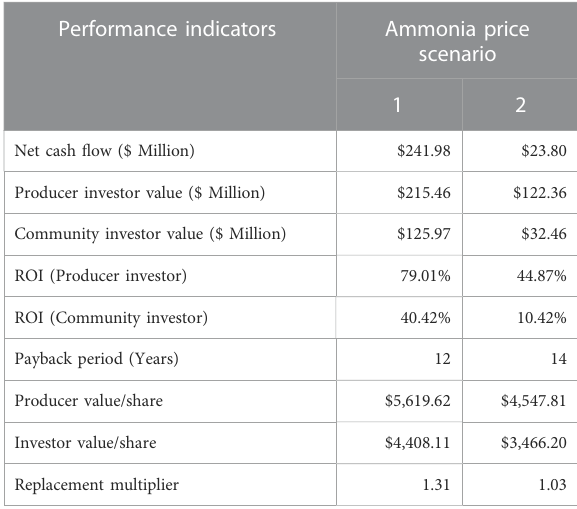
TABLE 8 Discounted performance indicators under debt fi nancing I (producers = 35%; community = 40%; debt = 25%) with a discount rate